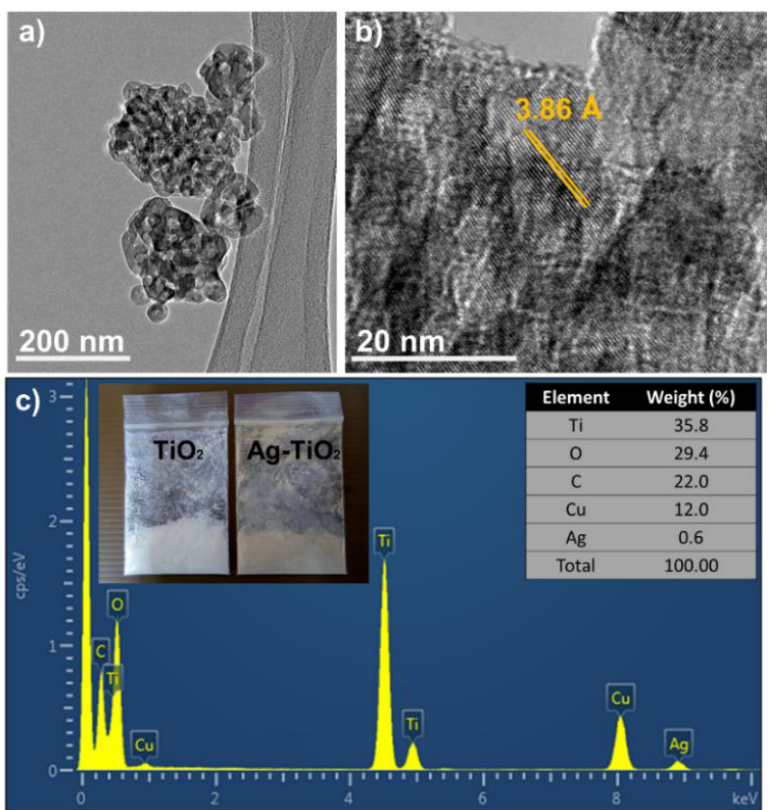
Figure 5. ( a ) TEM, ( b ) HR-TEM image of Ag-TiO 2 and ( c ) energy dispersive X-ray spectroscopy (EDS) spectrum for determination of elemental composition Ag-TiO 2 nanocomposites.